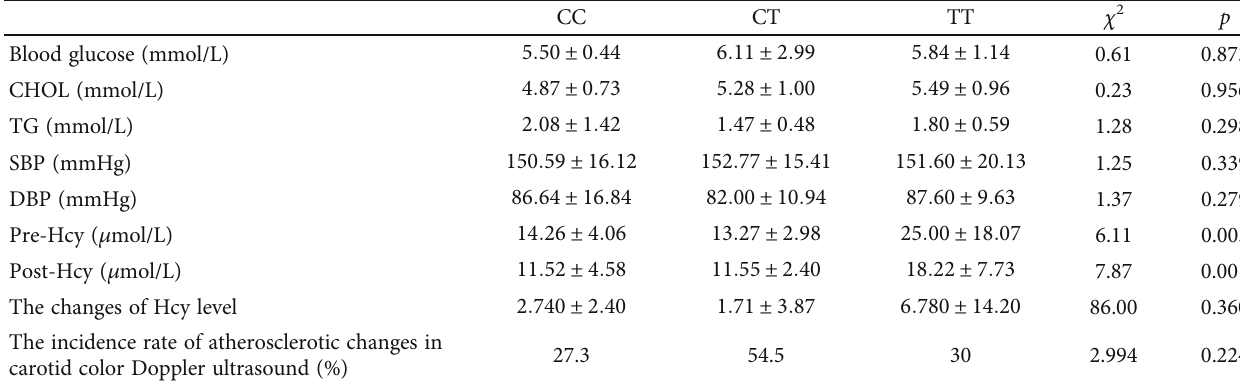
Table 2: Comparison of measured indicators among the three